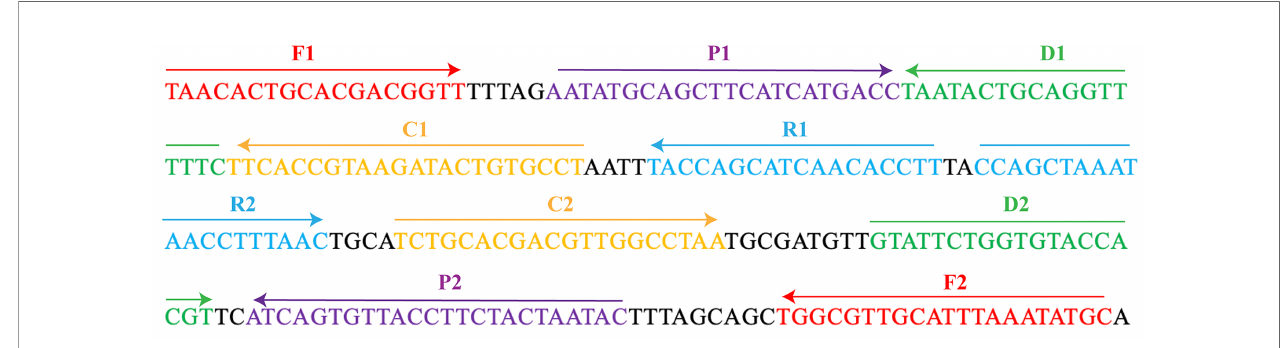
FIGURE 1 | The MCDA primers designed based on the OMP P6 gene. The location of the 10 primers were marked with different colors. Right arrows and left arrows indicated sense and